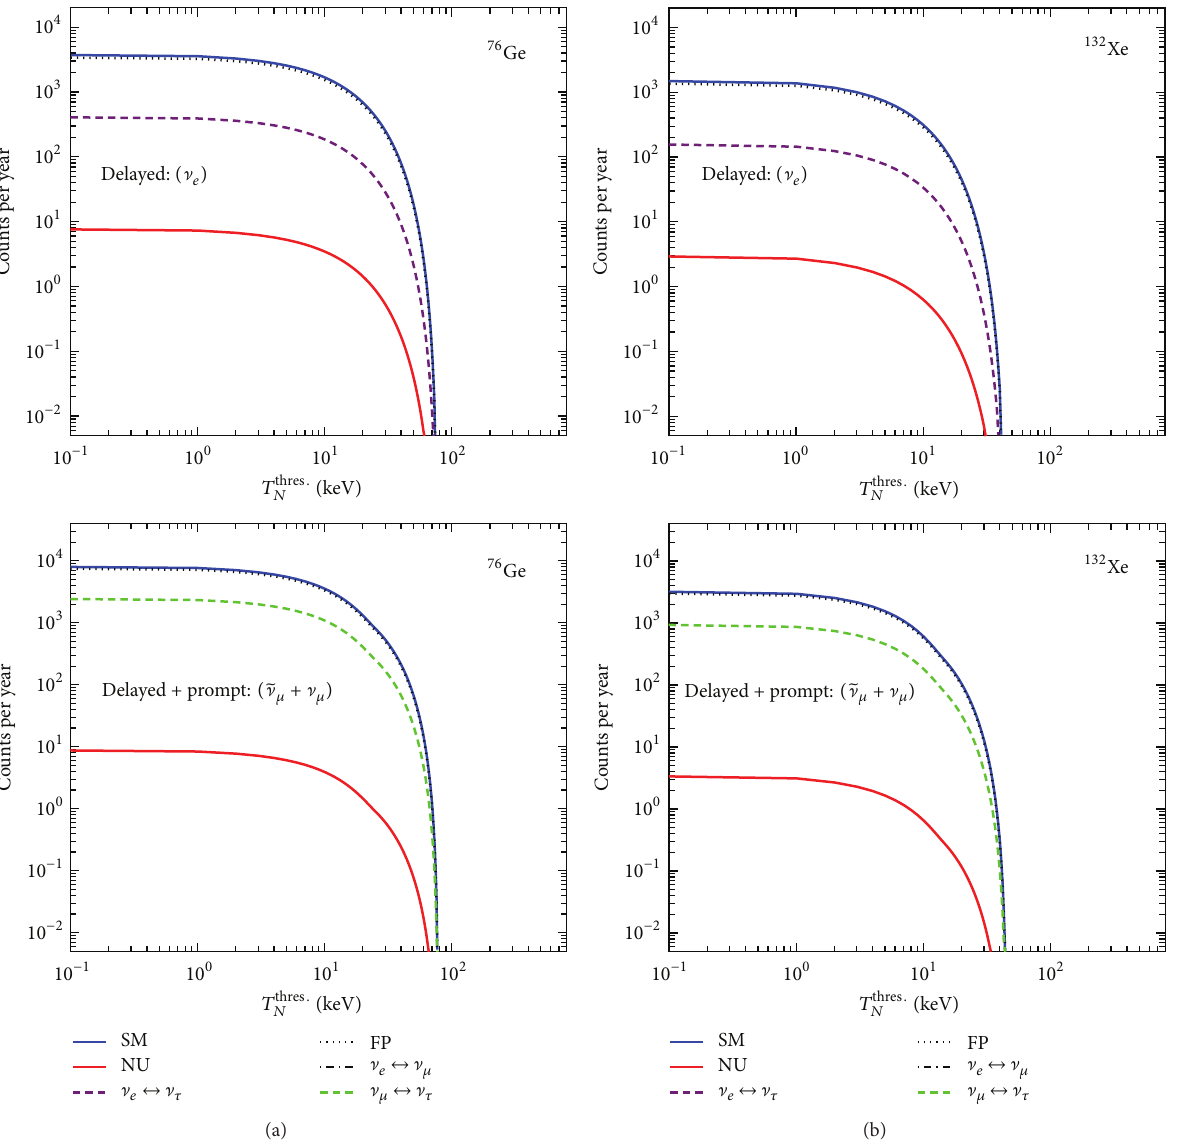
= 2.5 × 10 7 ] s −1 cm −2 ) and 100kg of liquid 132 Xe at 40 m ( Φ 𝛼